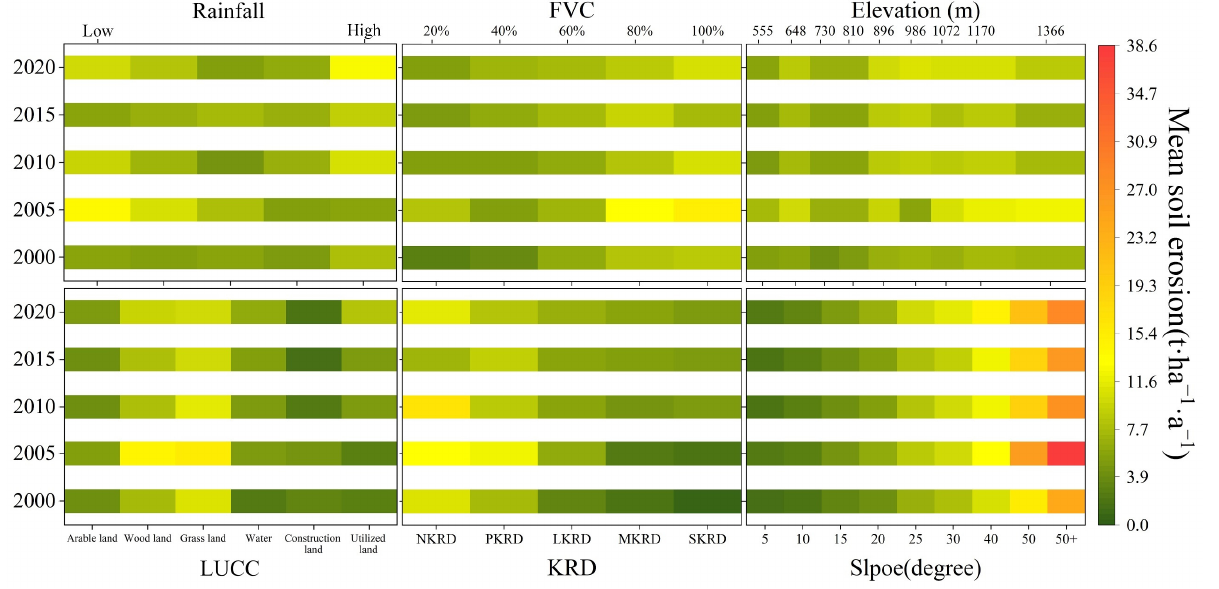
Figure 7. Factor classification and mean soil erosion values.